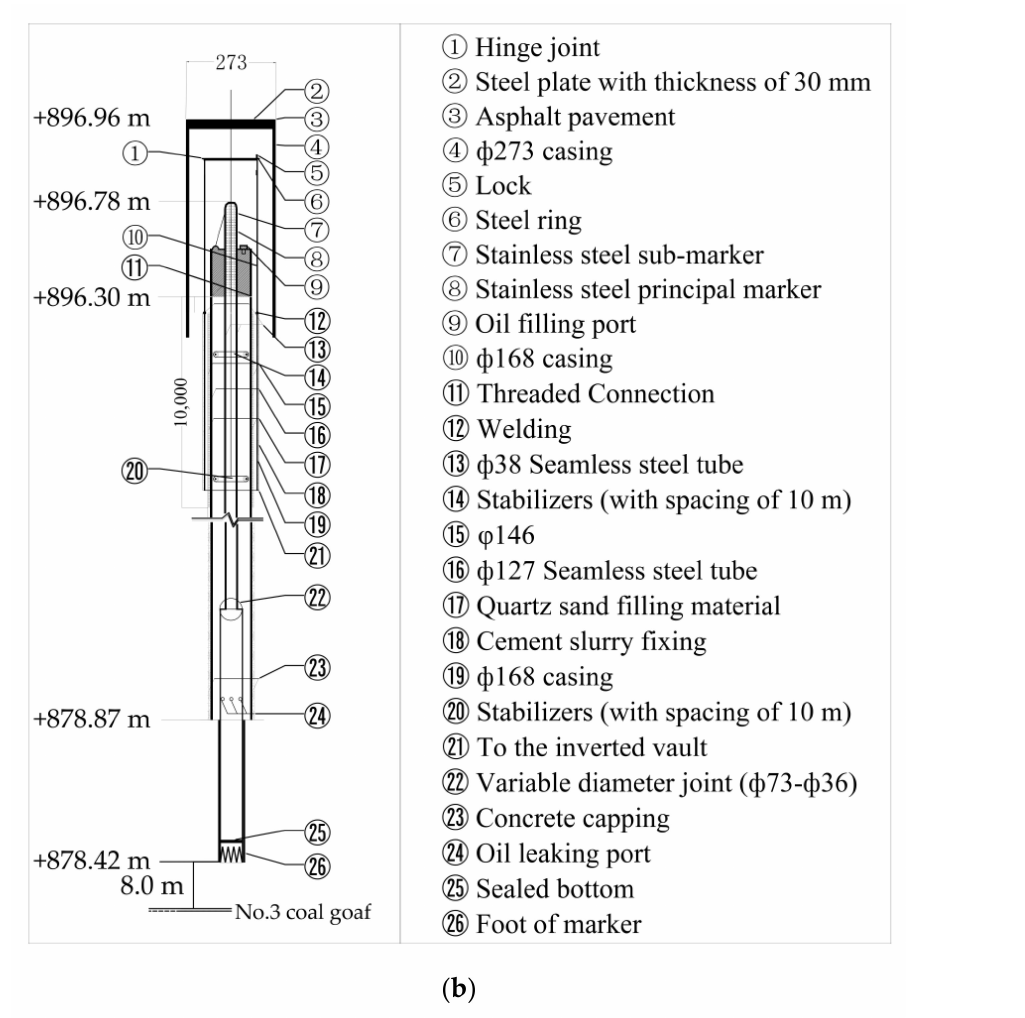
Figure 5. Bedrock marker installation diagram: ( a ) layout of boreholes; ( b ) structure of